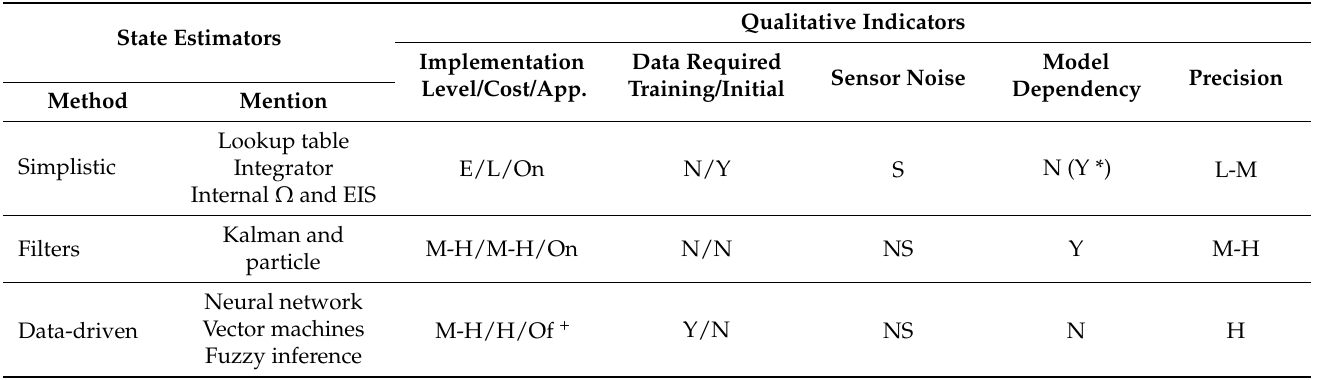
Table 4. Battery state estimators for electrified